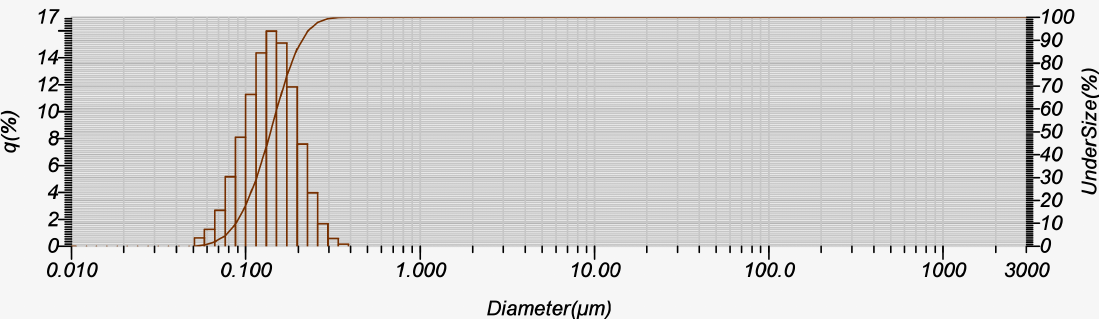
Figure 6. Distribution chart (LDS size) of SLN-gac oil.